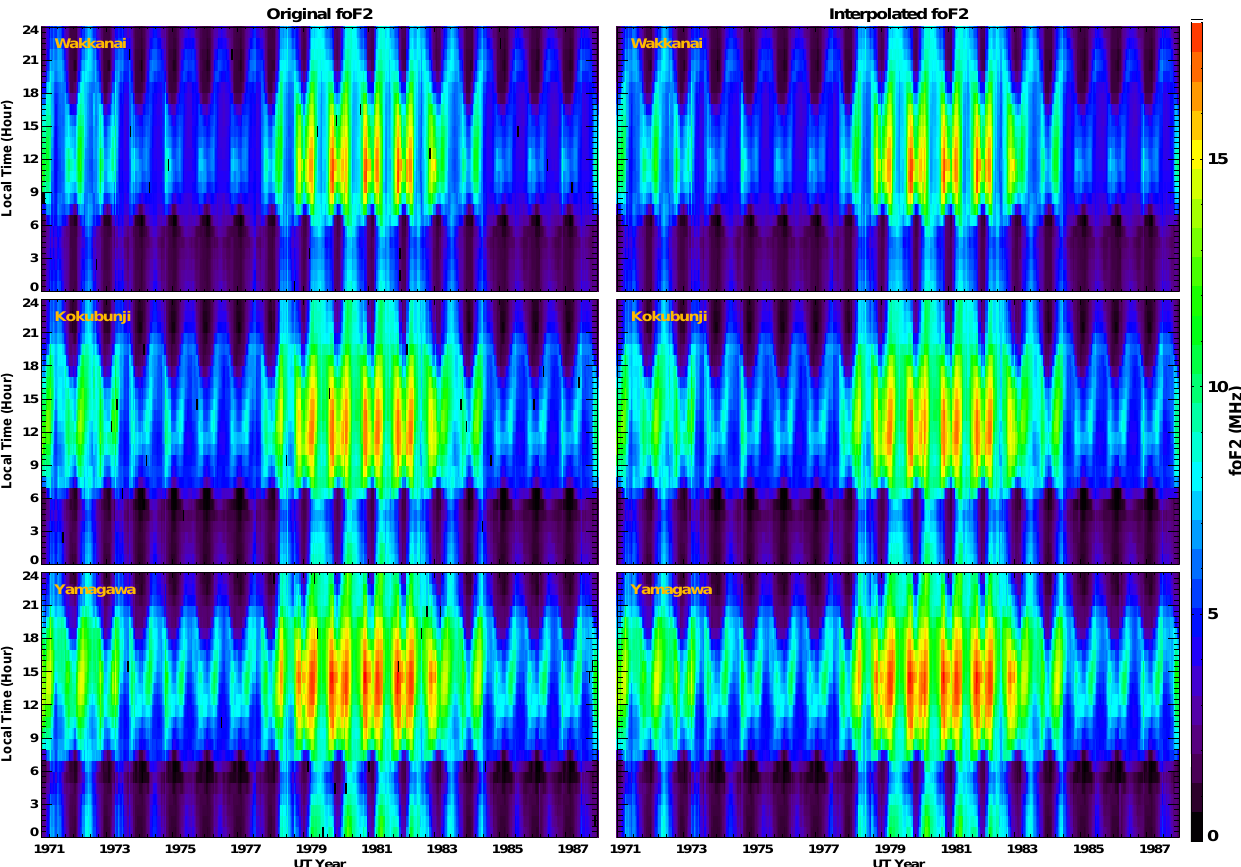
Fig. 1. Comparison among the original fo F2 (left panels) and interpolated fo F2 using similar-parameters method during the interval 1971– 1987 at three ionosonde